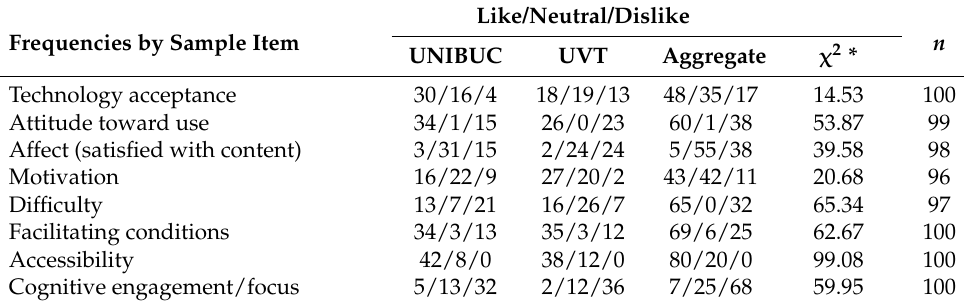
Table 1. Distribution of preferences (frequencies).